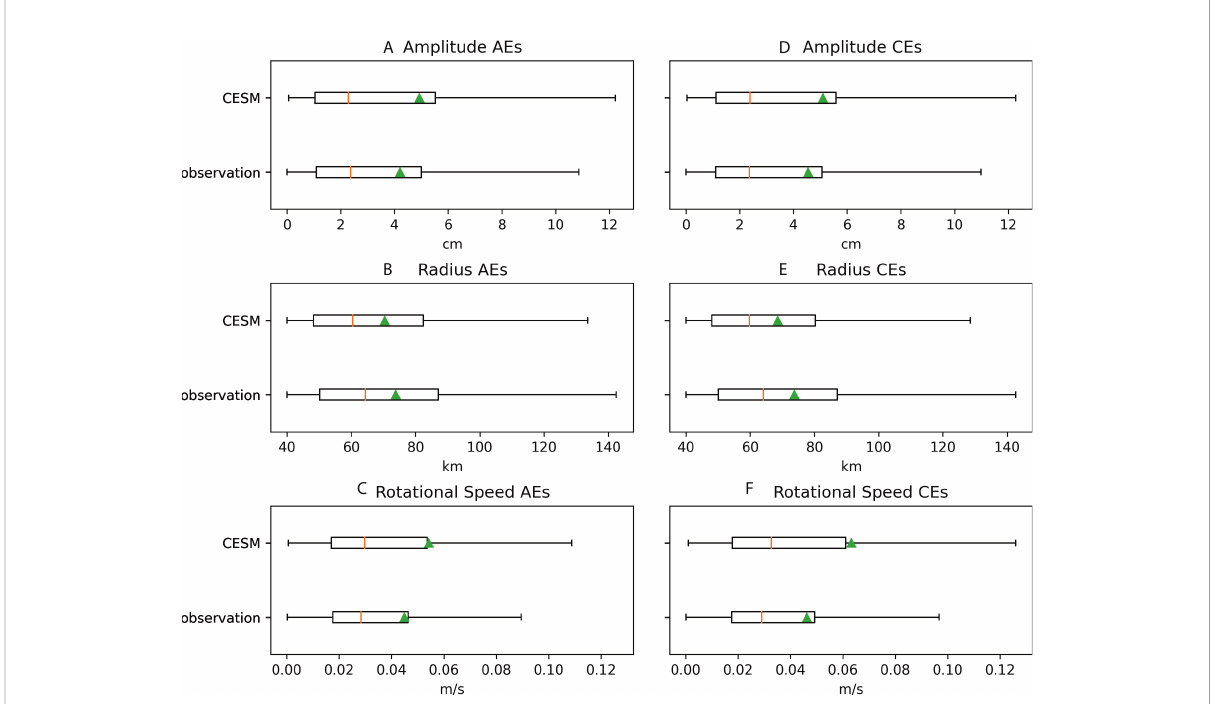
FIGURE 1 Boxplots of the (A, D) amplitude, (B, E) radius, and (C, F) rotational speed of AEs and CEs in the CESM and observations, respectively. Orange lines denote the median values, whereas green triangles denote the mean